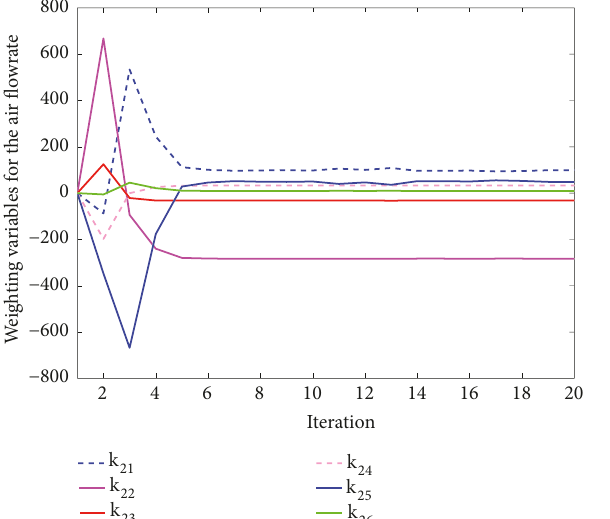
Figure 16: 𝐶 𝐹1 trajectory in Task 2.